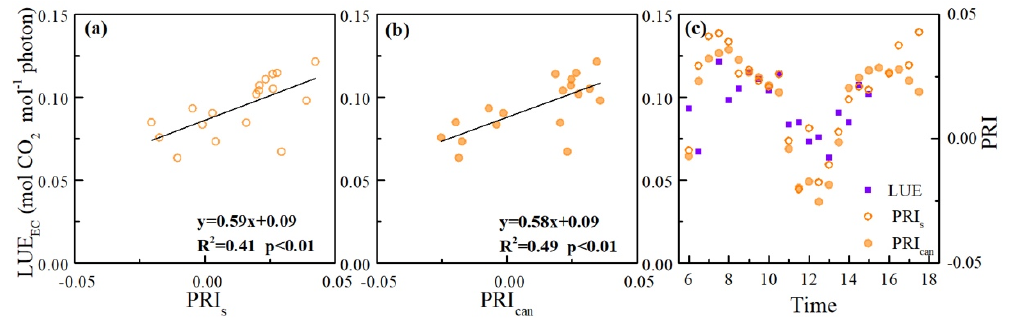
Figure 3. Linear regressions of half-hourly ( a ) single-angle observed PRI (PRI s ) and light use efficiency based on eddy covariance (EC) measurement (LUE EC ), ( b ) canopy PRI (PRI can ) and LUE EC , and ( c ) their diurnal variation on DOY 204 (23 July, 2018).